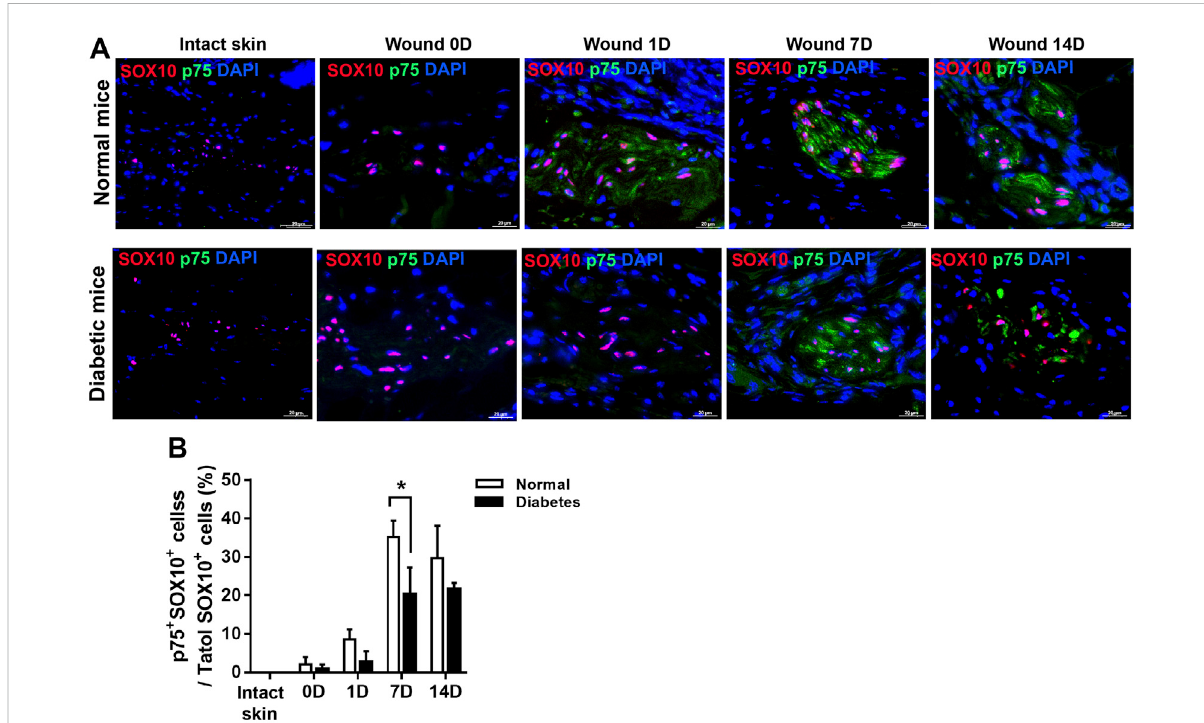
FIGURE 5 Diabetic wounds display reduced SC de-differentiation during cutaneous wound healing. (A) Representative immuno fl uorescence analyses of p75(green)andSOX10(red)innormalanddiabeticmiceatdays0,1,7,and14post-wounding. (B) Thepercentagesofp75 + SOX10 + SCsinnormaland diabeticmiceinintactskinandinthewoundbedatdays0,1,7,and14post-wounding.Dataarepresentedasmean±SD,* p < .05, n =6/group,two- way ANOVA, Bonferroni ’ s post hoc